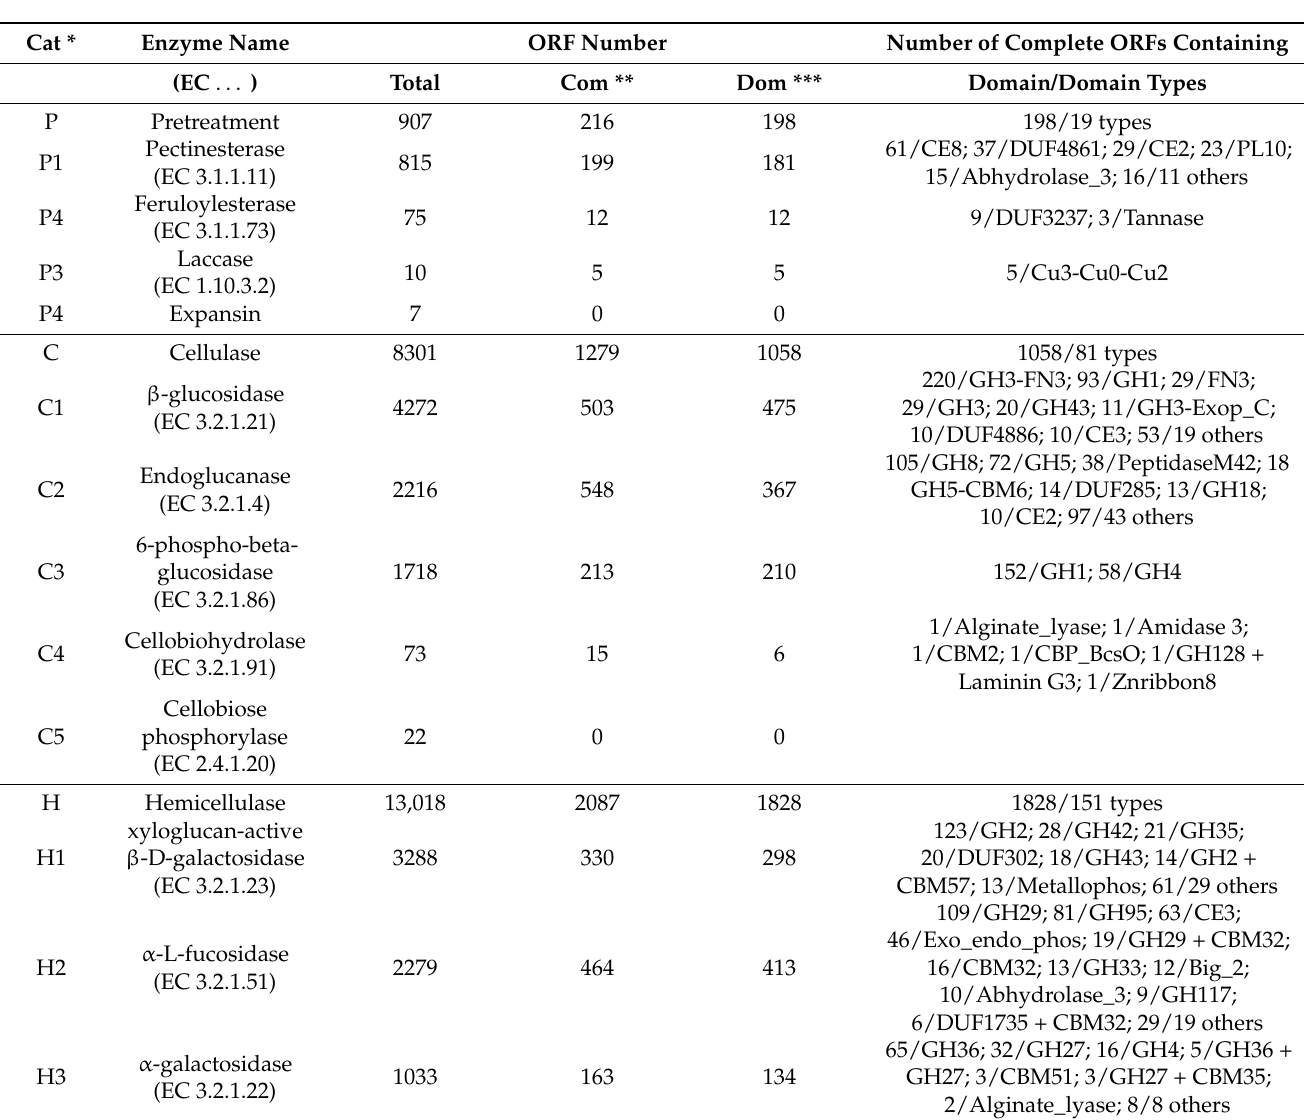
Table 4. Summary of ORFs encoding lignocellulases mined from the humus metagenomics DNA using KEGG database, Pfam, and HMMER